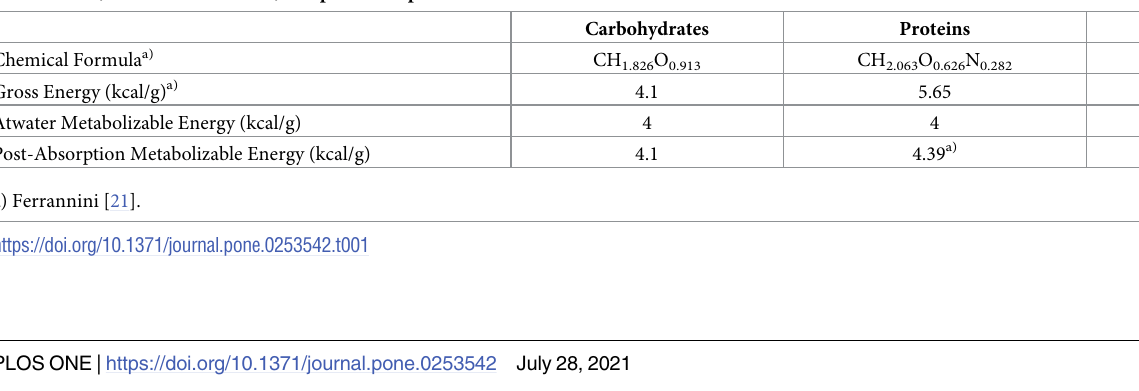
Table 1. GEI, Atwater coefficients, and post-absorption MEI for macronutrients in